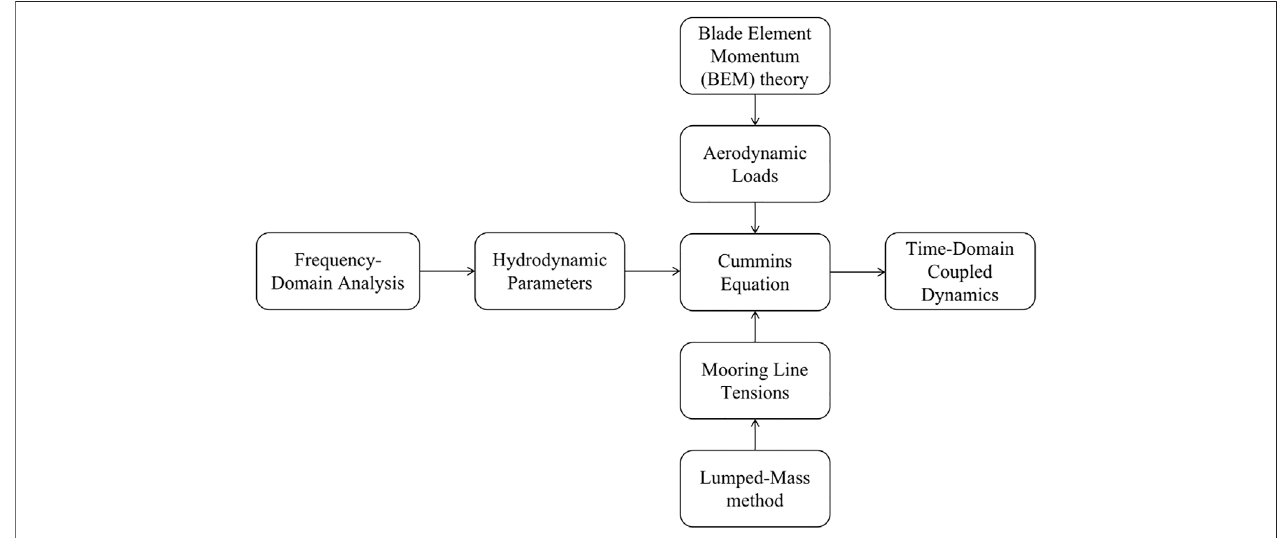
FIGURE 6 | Flowchart of time-domain analysis methodology.